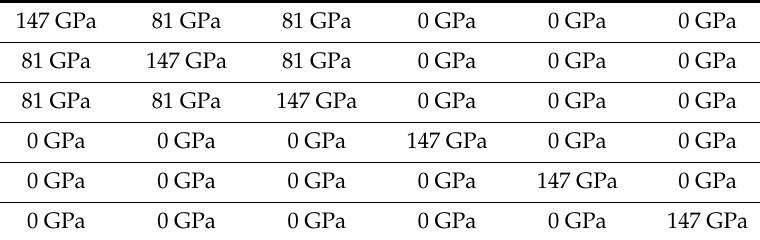
Table A2. The elastic constant matrix of the